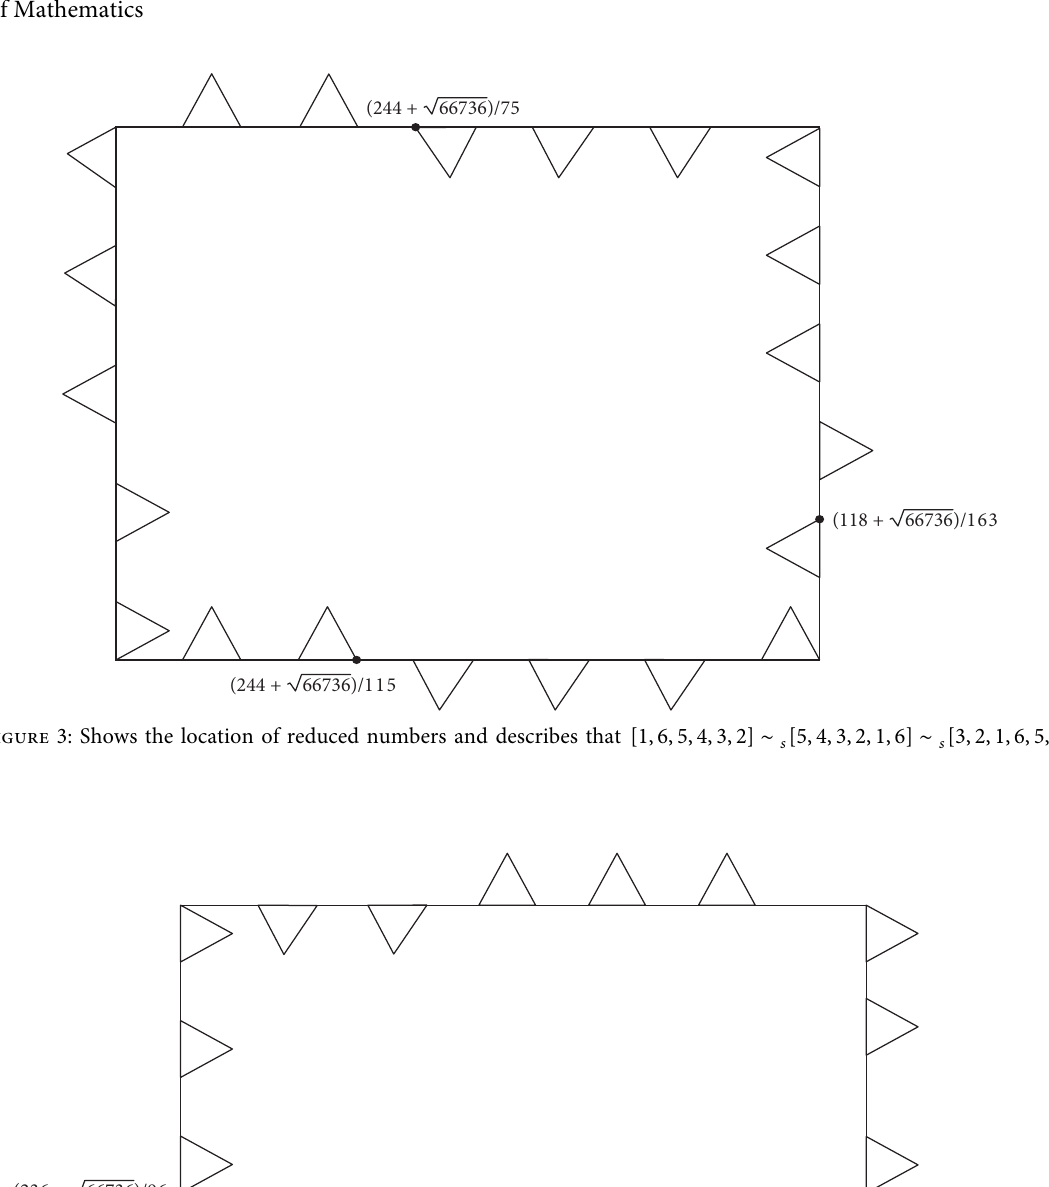
[ 4 , 3 , 2 , 1 , 6 , 5 ] ∼ [ 2 , 1 , 6 , 5 , 4 , 3 ] s s